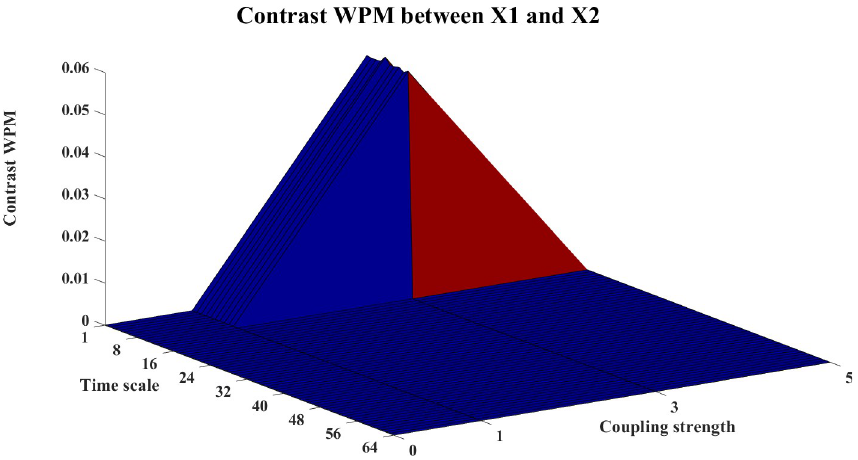
Fig 20. The contrast WPM information transfer for X1 ! X2. The 3D surface presents the contrast WPM information transfer (